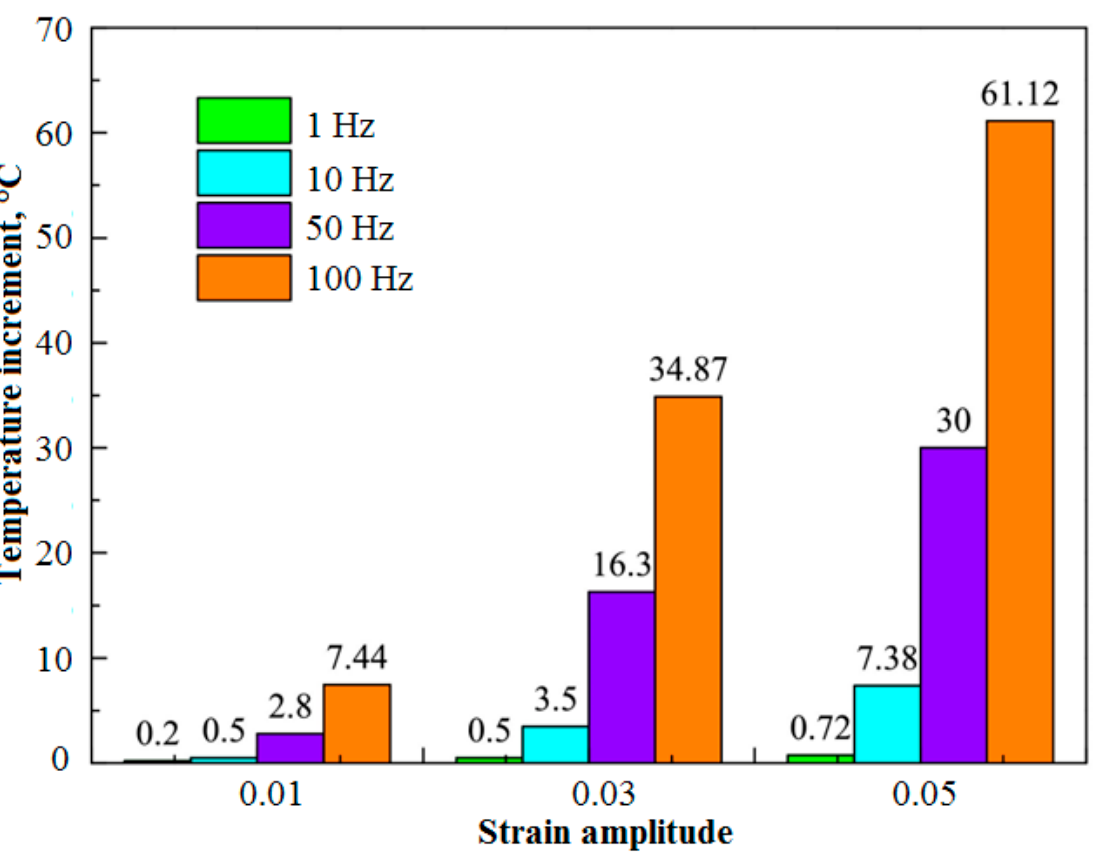
Figure 2. The influence of frequency and strain amplitude on the temperature of hydroxyl-terminated polybutadiene (HTPB) propellant under cyclic fatigue test, adapted with permission from Ref. [7].